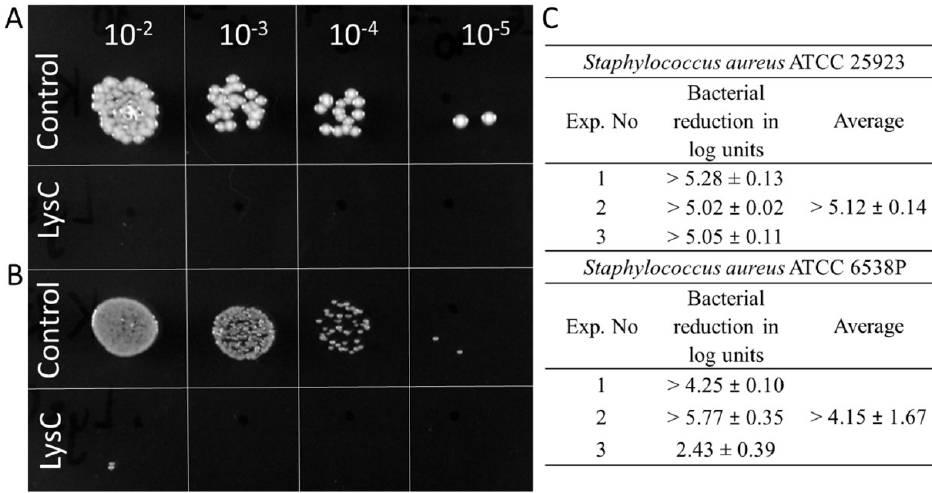
Figure 3. Antimicrobial activity of LysC. ( A ) Activity against S. aureus ATCC 25923; ( B ) Activity against S. aureus ATCC 6538P. Both bacteria ( > 10 5 ) were mixed with LysC dissolved in 20 mM HEPES bu ff er, pH 7.4, to a final volume of 300 µ L and a final enzyme concentration of 500 µ g / mL. The mixtures were incubated at 37 ◦ C for 1.5 h. Aliquots of 5 µ L, containing serial 10-fold dilutions prepared in 20 mM HEPES bu ff er, pH 7.4, were spotted onto tryptic soy broth (TSB) agar plate. The plate was incubated overnight, and then photographed; ( C ) Serial 10-fold dilutions of controls and reactions with LysC, in a volume of 100 µ L were spread onto TSB agar plates. After an overnight incubation at 37 ◦ C, colony forming units (CFUs) were counted and the antibacterial activity was reported as bacterial reduction in logarithmic units relative to the untreated control.